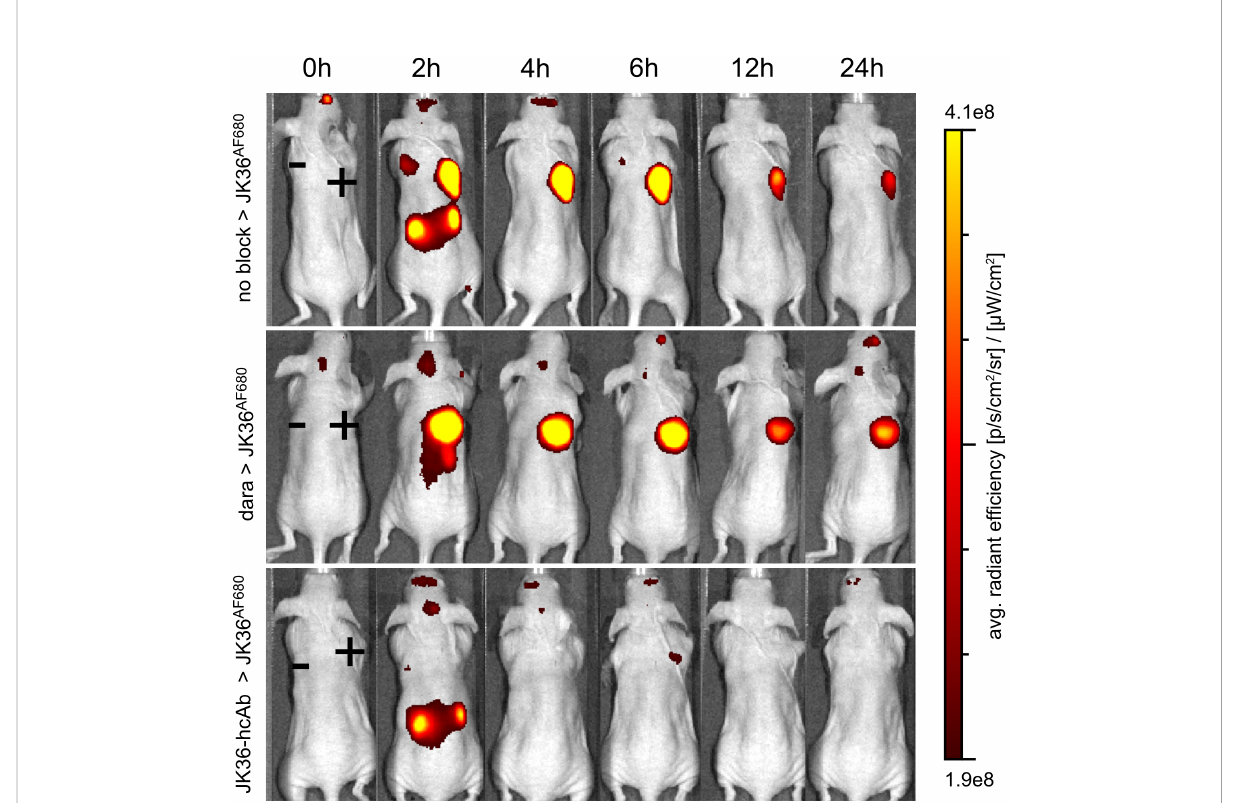
FIGURE 4 Speci fi c in vivo imaging of subcutaneous CD38+ tumors using nanobody JK36 AF680 in saline-, daratumumab-, and JK36-hcAb-pretreated mice. All mice were analyzed six days after subcutaneous injection of CD38-positive YAC-1 cells on the right shoulder (+) and CD38-negative YAC-1 cells on the left shoulder (-). Prior to imaging, mice were pretreated for 24 hours with either isotonic saline (n=10, positive control, top row), daratumumab (n=10, middle row), or JK36-hcAb (n=10, speci fi city control, bottom row). Near-infrared fl uorescence in vivo imaging was performed before (0h) and at the indicated time points after the injection of 50 µg of nanobody JK36 AF680 . Signal intensities of all injected mice and imaging time points are all equally leveled to allow direct and fair visual